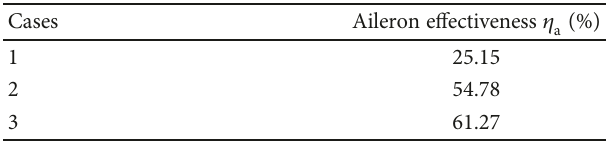
Table 4: Comparison of aileron e ff ectiveness.